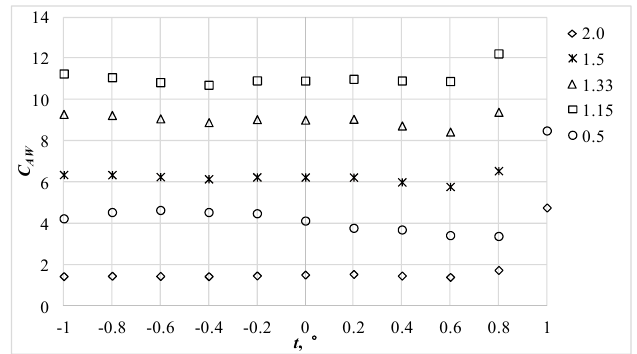
Figure 11. Influence of trim on added resistance coe ffi cient in regular